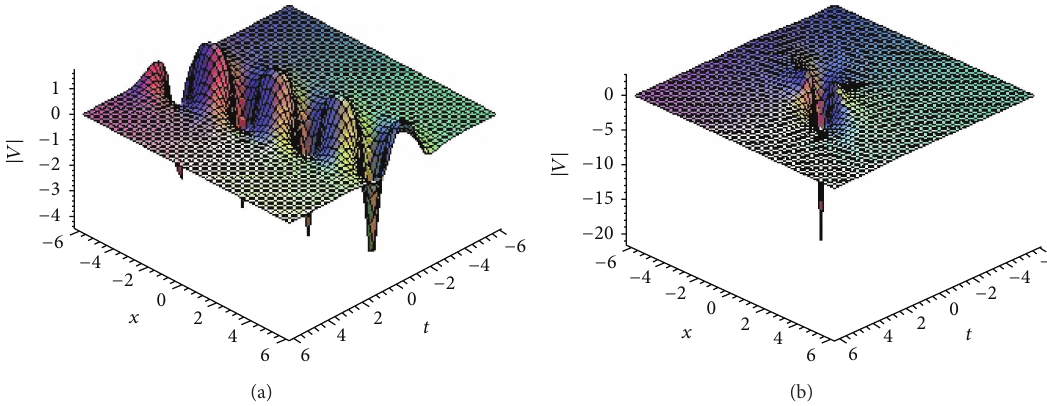
Figure 5: (a) Dark breather structure 𝑉 in DSII. (b) Dark rogue wave 𝑉 in